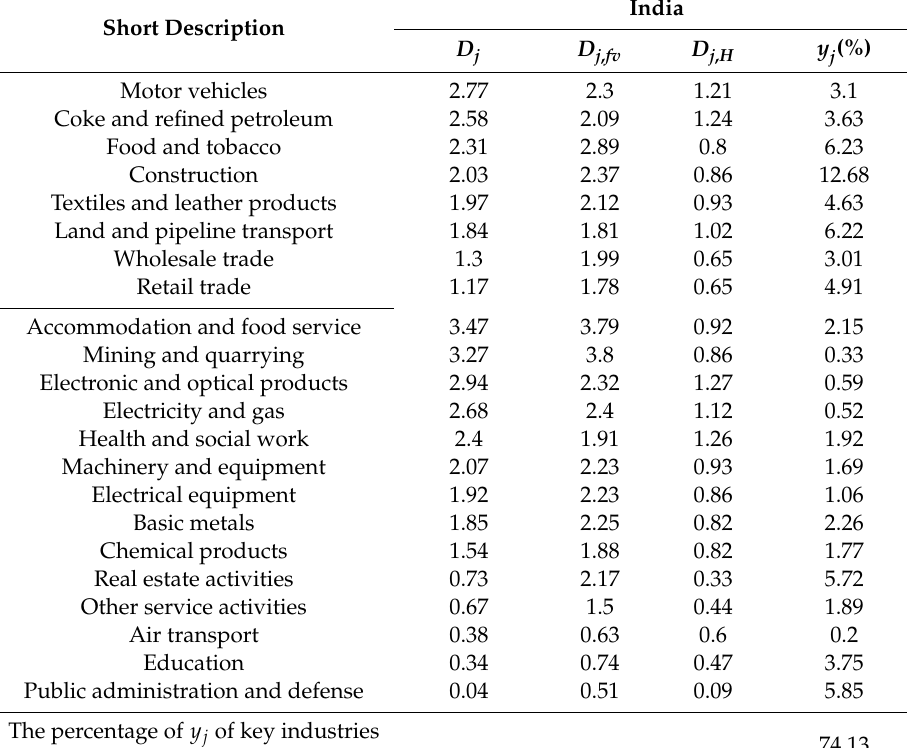
Table 5. Multiplicative SDA of EEI di ff erence of key sectors in India in 2014. Short